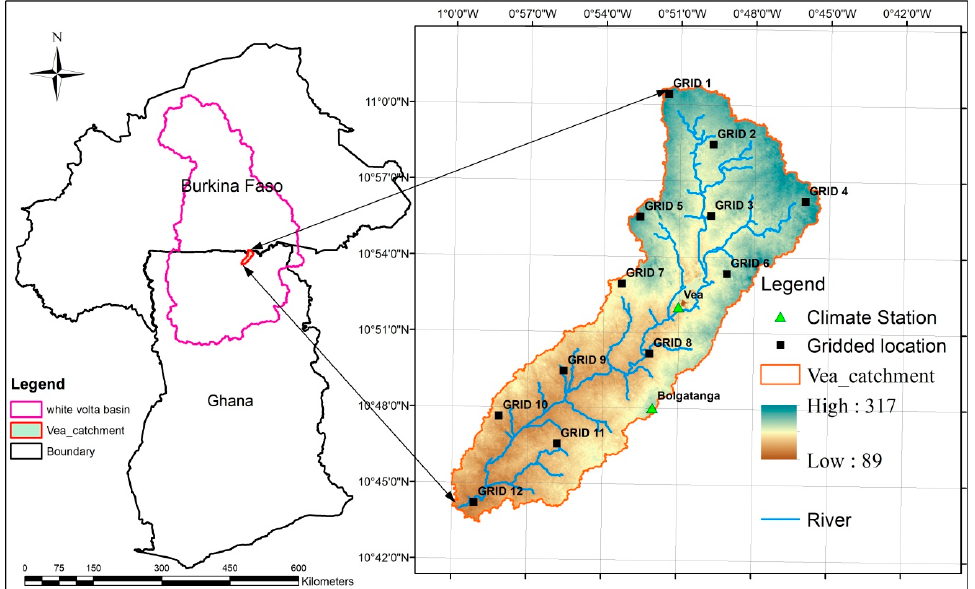
Figure 1. Map of the Vea catchment showing station and gridded precipitation locations within a 5 km grid.